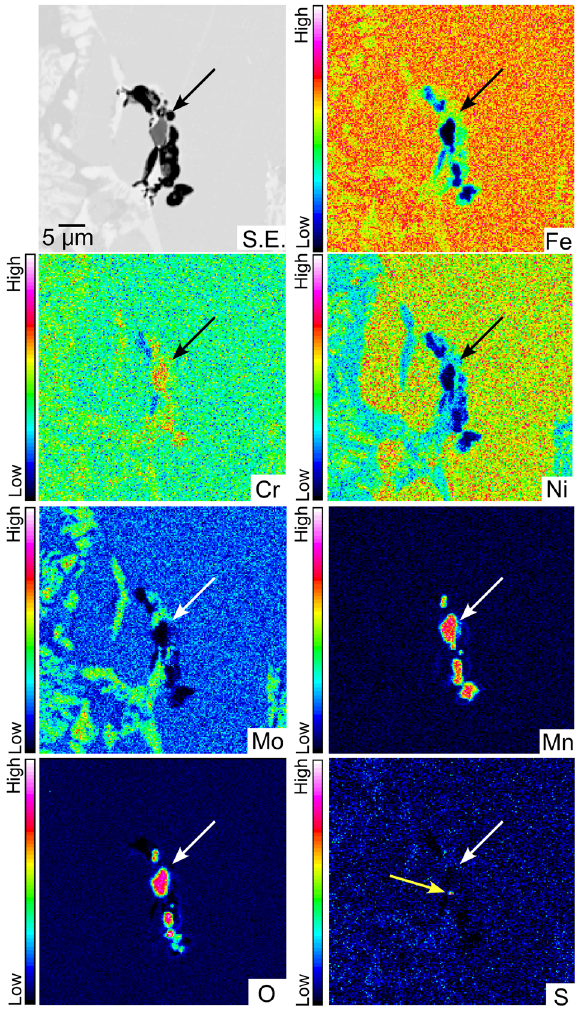
Fig. 12 The pitting corrosion on the 1 × 1 mm electrode. A SEM image of the corroded area (pit) shown in Fig. 11c and the corresponding EPMA maps. Black and white arrows indicate the same position. Yellow arrow indicates the S signal